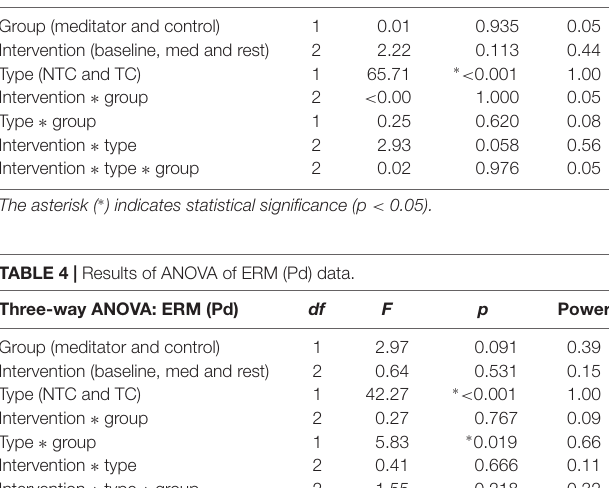
distractor absent trials ( t ( 50 ) = − 0.549, p = 0.586) or the NTC condition ( t ( 50 ) = − 0.598, p = 0.553). These results indicate